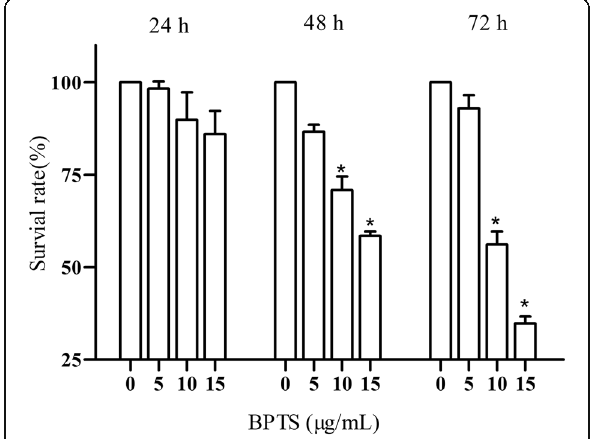
Fig. 1 Effect of BPTS on proliferation of MDA-MB-231 cells. Results are presented as a percentage of the 0 μ g/mL BPTS group. * P < 0.05 vs. 0 μ g/mL of